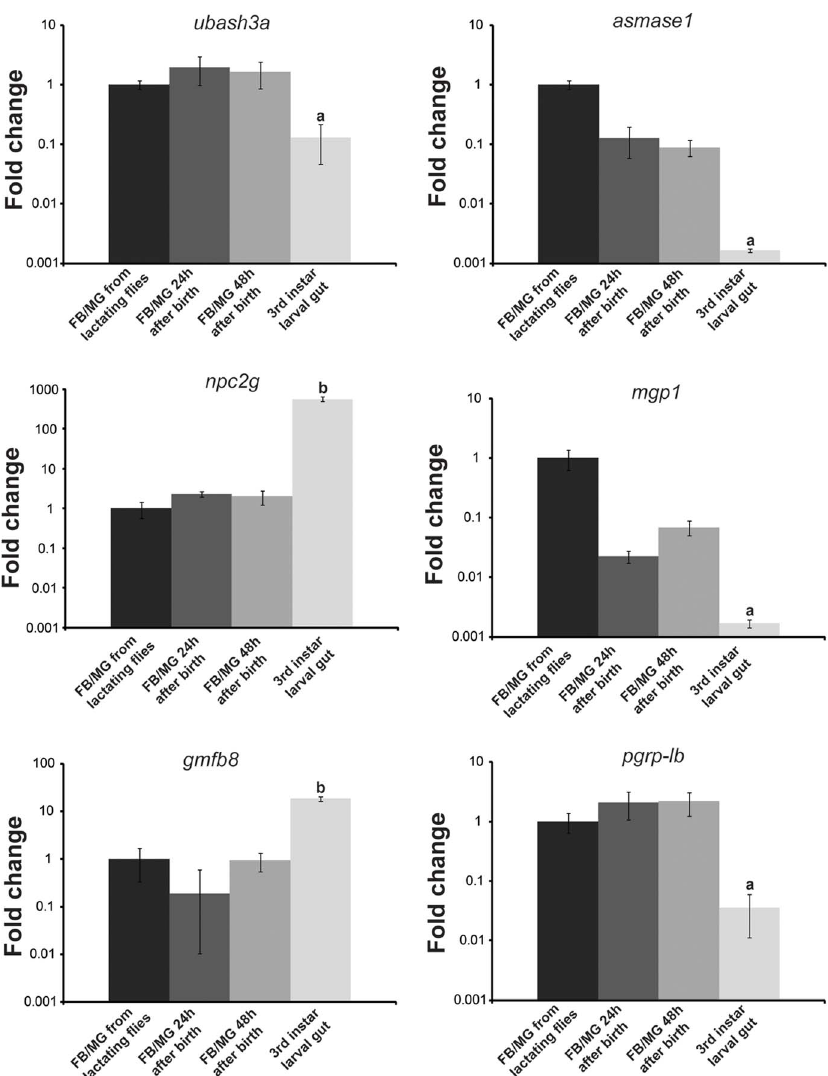
Figure 6. Validation of specific highly abundant proteins within the milk proteome. FB/MG, fat body/milk gland analyzed from lactating flies, 24 hours after birth and 48 h after birth along with 3rd instar larval gut. Transcript levels were determined by qPCR using a CFX PCR detection system (Bio-Rad, Hercules) and data were analyzed with CFX manager software version 3.1 (Bio-Rad). Data represents the mean 6 SE of three replicates and was normalized to tubulin . a (lower) and b (higher), denotes significant difference by ANOVA with Tukey’s test at P , 0.01 in comparison to the other samples.